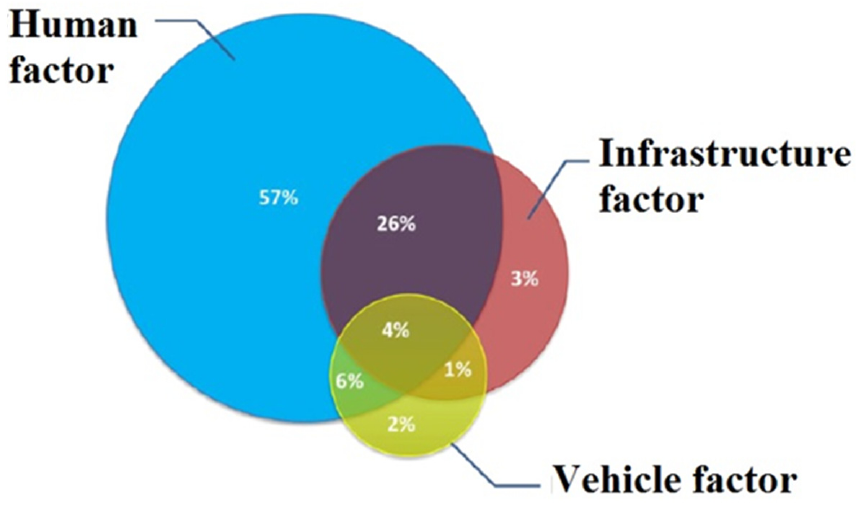
Figure 1. Interaction of the concurrent factors on road crashes. Nevertheless, speed is said to be the key factor in serious and fatal crashes involving pedestrians, with a great influence on injury severity of pedestrians [5,10]. When vehicles travel below 30 km/h, the collisions between motorized vehicles and pedestrians are much less likely to happen, and if they occur, they do not normally result in fatality [10]. Correlations between the risk of pedestrian fatality and the speed impact have been established (Figure 2)